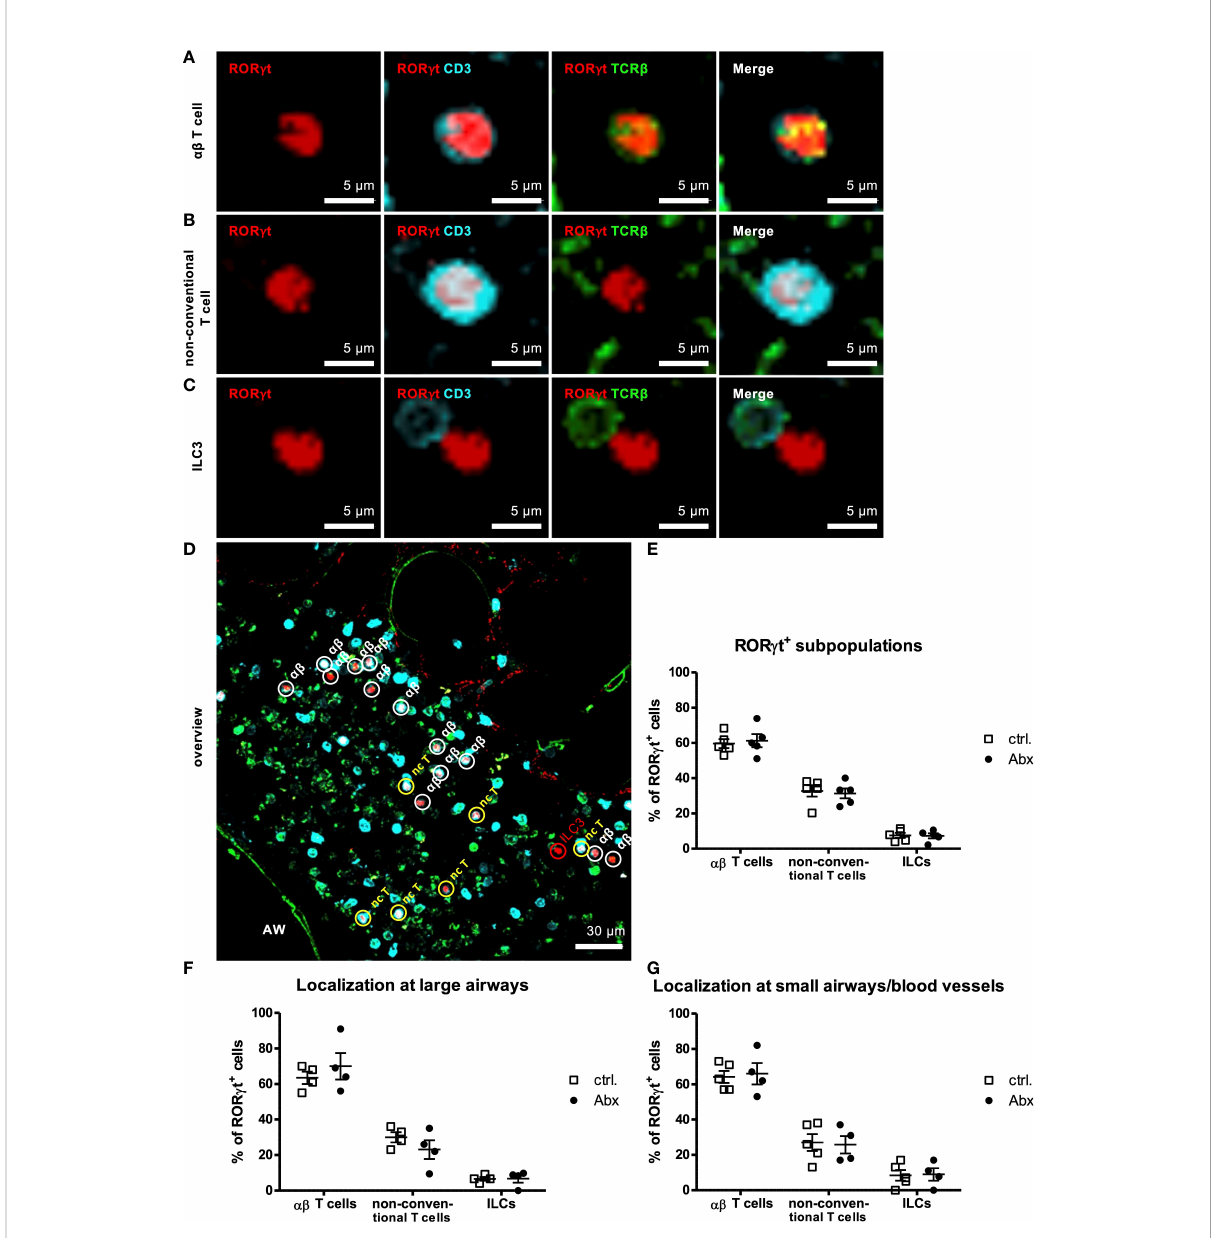
FIGURE 5 Prenatal antibiotic exposure of dams does not in fl uence localization of offspring pulmonary ROR g t + subpopulations in situ . C57BL/6 mice were treated with vancomycin, ampicillin and gentamycin (all at 1.0 mg/mL)(Abx) from prenatal day 15 until birth. Mice treated with sucralose served as controls (ctrl.). At 6-8 weeks, offspring C57BL/6 mice were immunized i.p. with 10 µg/100 µL of HDM. Seven days later mice received an additional i.p. injection of HDM. After 14 and 21 days mice were treated with 100 µg/40 µL HDM i.t. 72 h after the last treatment 300 µm lung sections of agarose fi lled lungs were prepared. Staining with anti-ROR g t (red), anti-CD3 (turquoise) and anti-TCR b (green) allowed discrimination of CD3 + TCR b + ab T cells (A) , CD3 + TCR b - non-conventional T cells (B) and CD3 - TCR b - ILC3s (C) . Stained slices were evaluated with laser scanning confocal microscopy generating Z-Stacks. (D) A representative overview of a large airway is shown. Frequencies of ab T cells, non- conventional T cells (nc T) and ILC3s among ROR g t + cells were determined in total lungs (E) around large (F) and small airways/blood vessels (G) . Abbreviations: AW, airway. Data are representative of at least four independent experiments. Scatter plot with mean ± SEM. n = 4-5 mice. Each dot represents the Z-stack of one